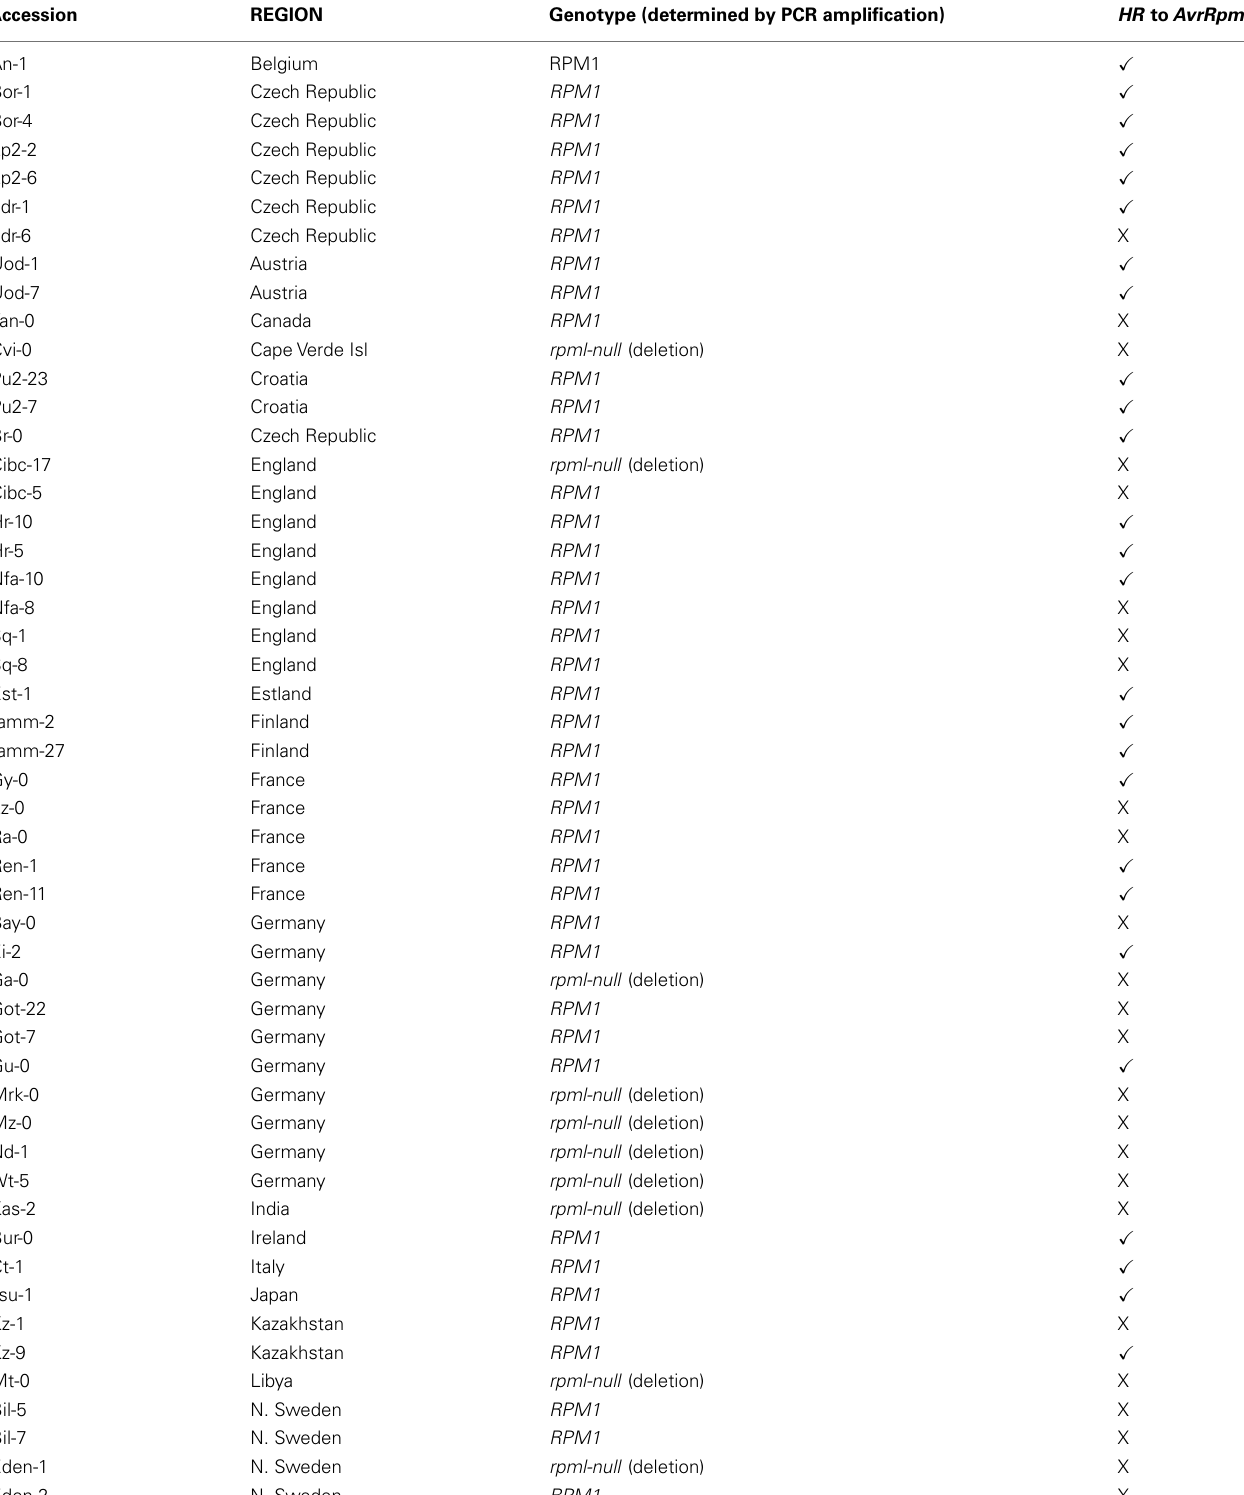
TableA2 | RPM1 genotypes and resistance phenotypes across world accessions.